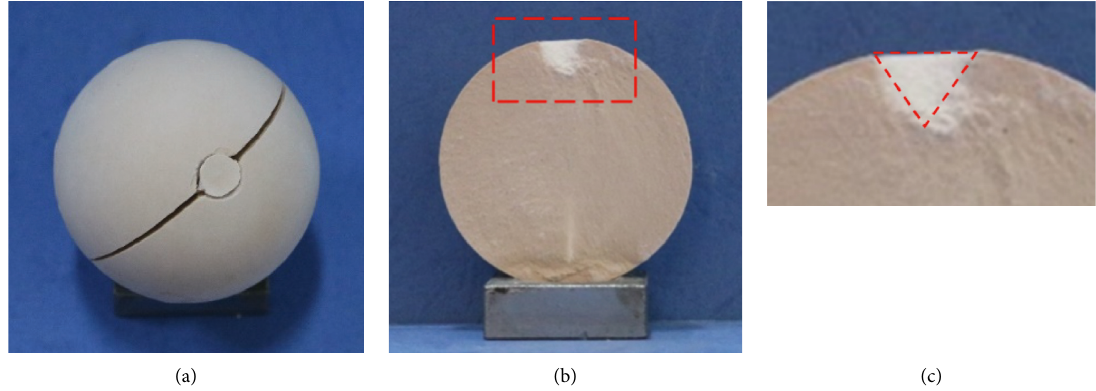
Figure 13: Morphologies after breakage: (a) contact point, (b) broken surface, and (c) cone